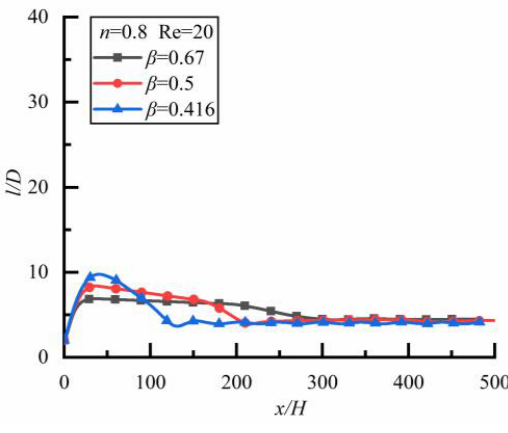
Figure 14. Relationship of particle spacing l/D and power-law index n ( Re = 20, β = 0.5), and power-law index n ( Re = 20, β = 2).